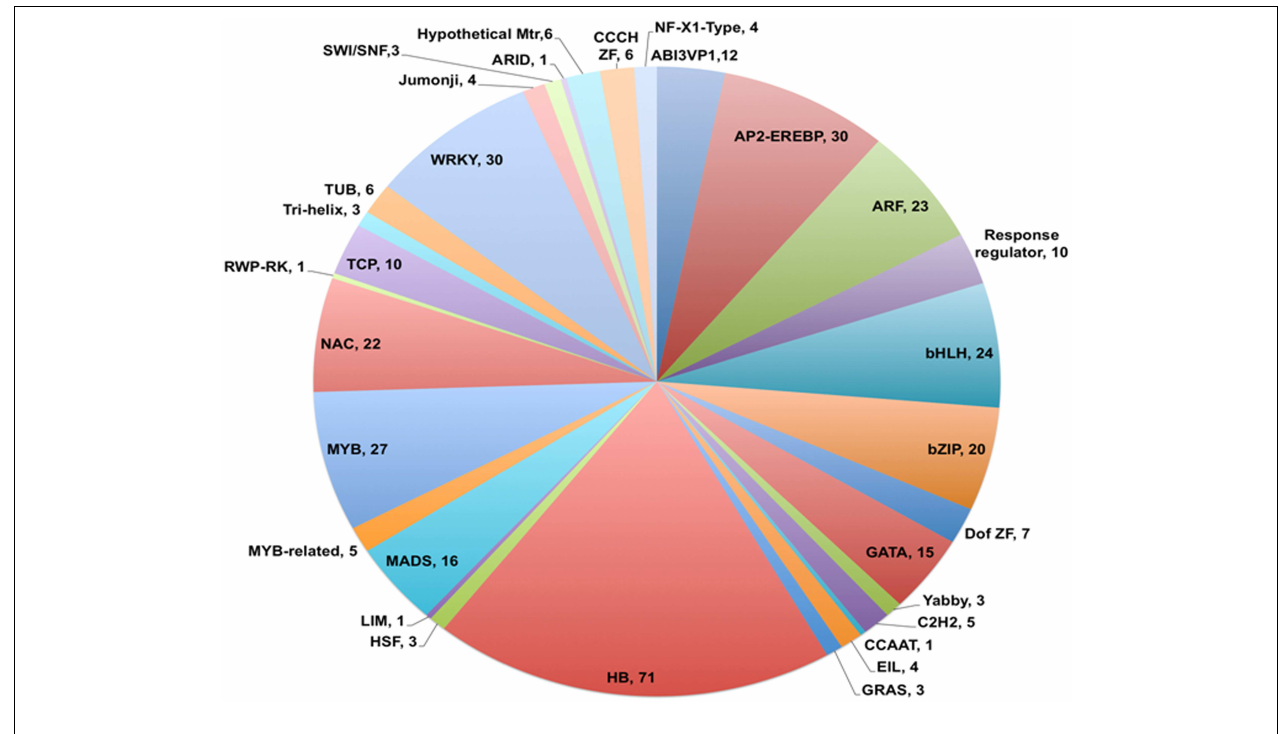
FIGURE 4 | Distribution of V. faba transcripts into different transcription factor families. Pie chart showing families of transcription factors and total number of members identified for each family. Homeobox family members (HB) contributed 19% of the total